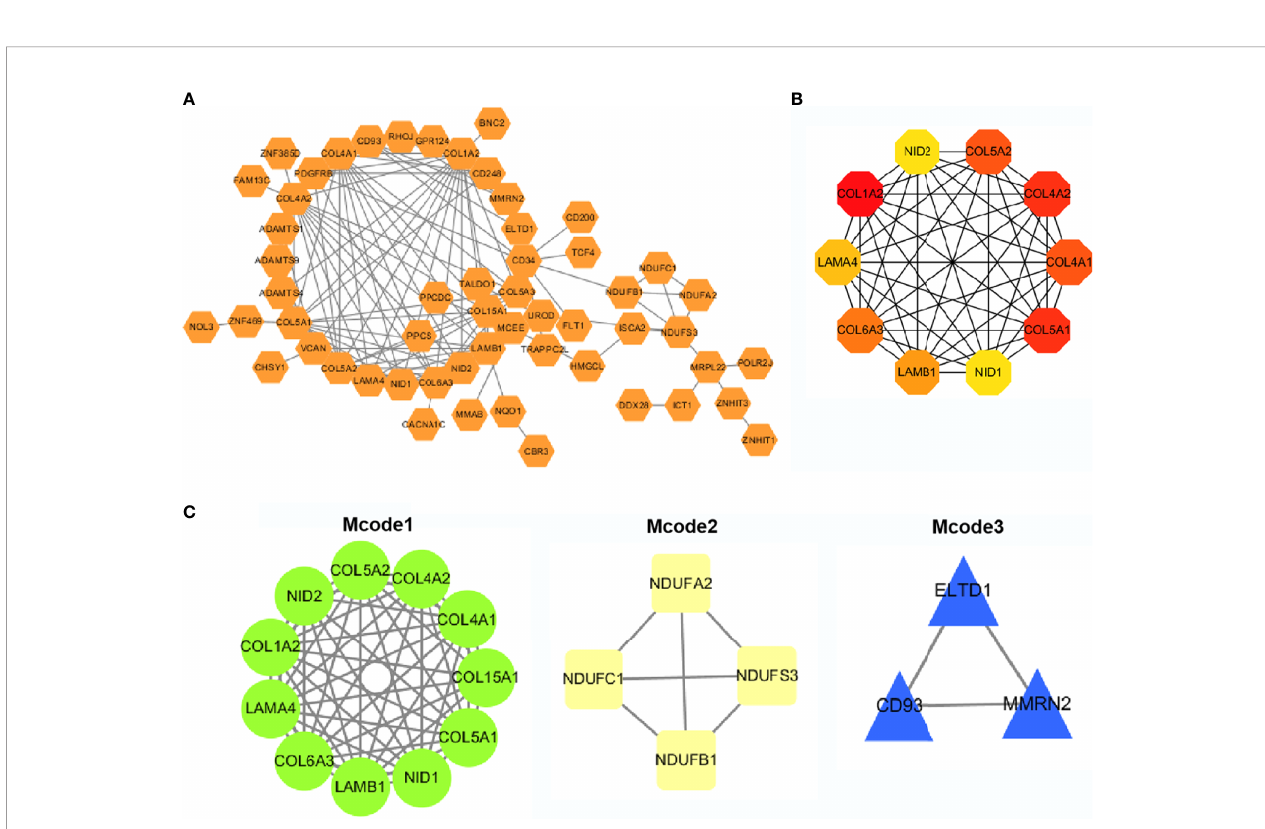
FIGURE 6 | PPI network analysis. (A) PPI network analyses of the top 50 genes that positively and negatively correlated with ADAMTS9, and visualized with Cytoscape. (B) Ten Hub gene selection from the entire PPI network using the cytoHubba plug-in of Cytoscape software. (C) The Mcode plug-in in Cytoscape was used for moduled analysis, and fi nally three modules were obtained. PPI, Protein – protein interaction.